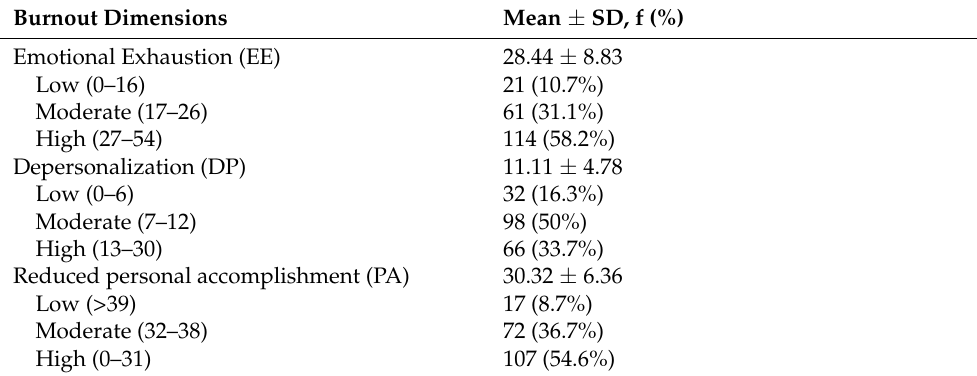
Table 3. Classification of health professionals by the dimensions of